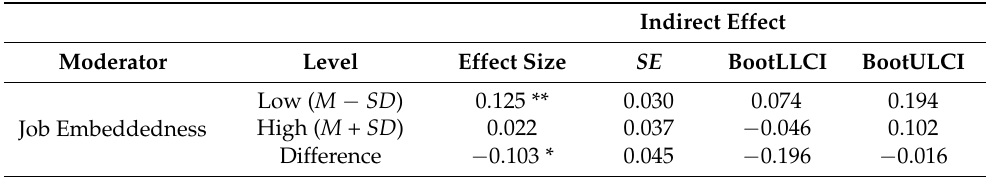
Table 8. Conditional indirect effects of performing